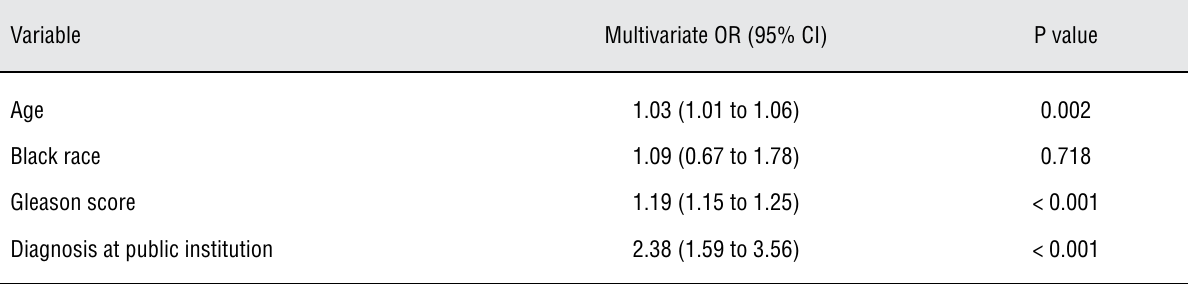
Table 3 - Multivariate analysis of factors associated with metastatic disease upon diagnosis in the total sample of 1915 patients. Variable